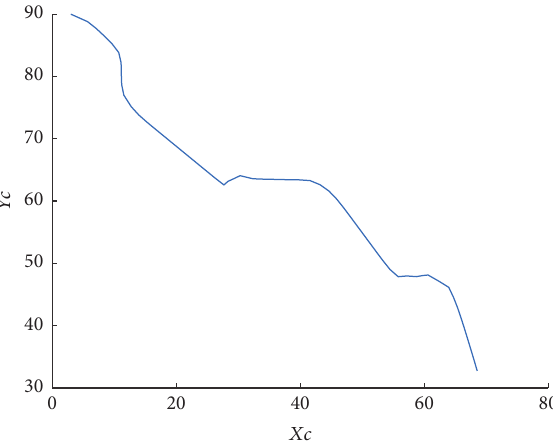
Figure 13: The trajectory of the OMR controlled by dynamics controller in 𝑋 𝑐 𝑂 𝑐 𝑌 𝑐 coordinate.